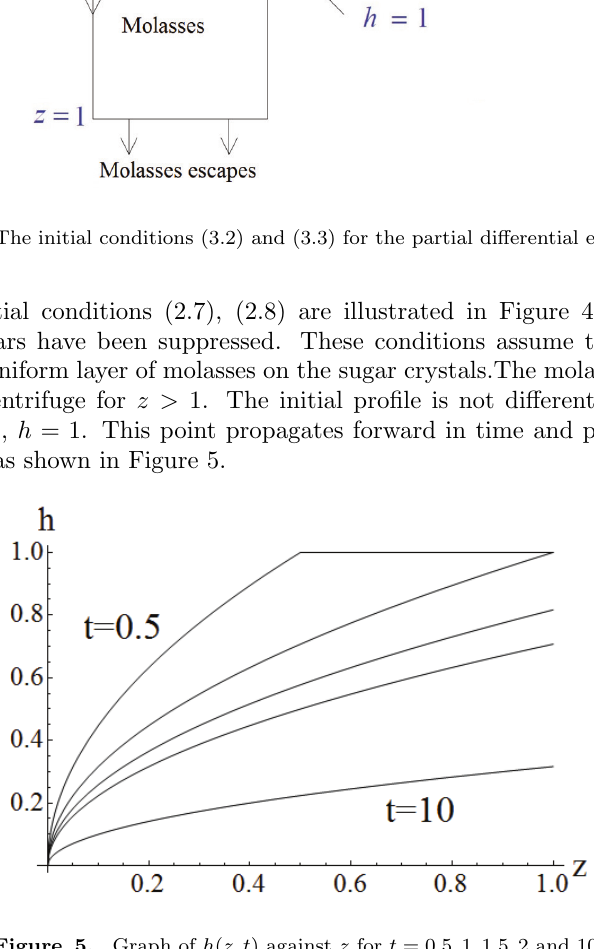
Figure 5. Graph of h ( z,t ) against z for t = 0 . 5 , 1 , 1 . 5 , 2 and